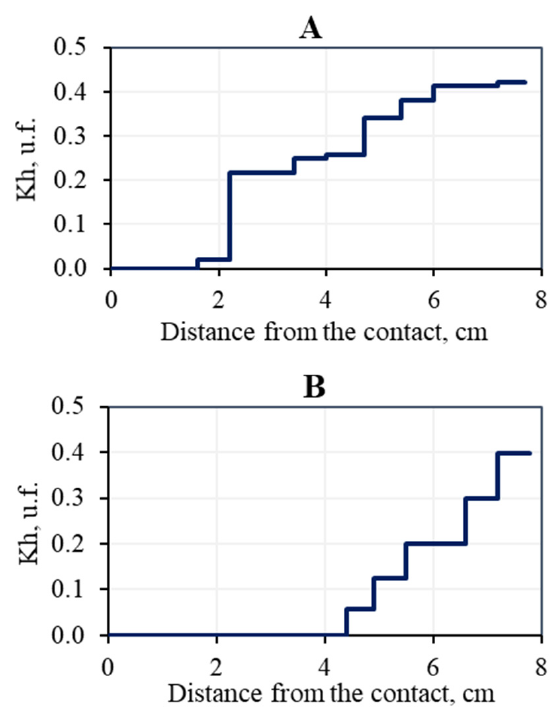
Figure 10. Variations of hydrate coefficient ( K h ) along frozen hydrate-bearing sand samples ( 𝐾 (cid:3035)(cid:3036)(cid:3041) ~0.4, W = 12%) after four hours of interaction with 0.1 N ( A ) and 0.2 N ( B ) NaCl solutions, at − 6.5 °C and 4.0 MPa.